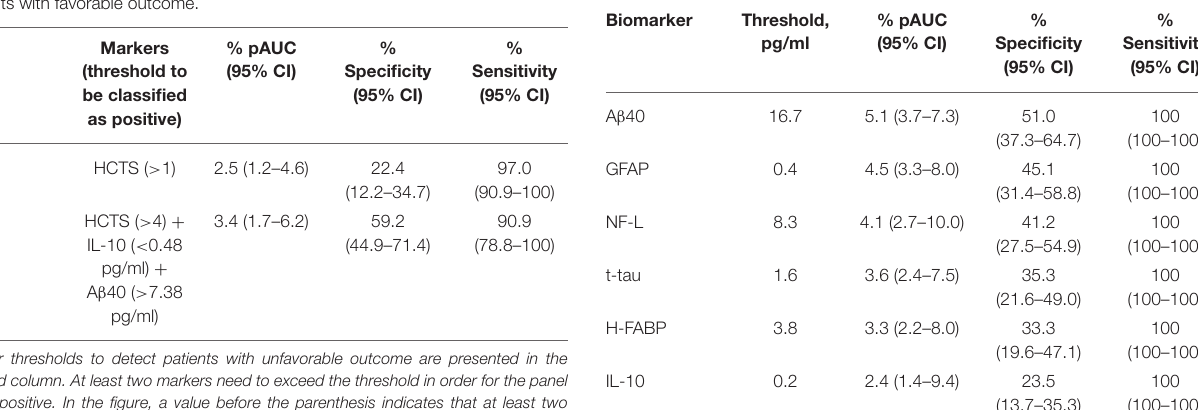
TABLE 6 | Individual abilities of eight different biomarkers in discriminating patients with favorable and unfavorable outcomes without head imaging abnormalities sorted by partial area under the curve of the receiver operating characteristic (all, n = 55; favorable outcome, n = 51; unfavorable outcome, n =